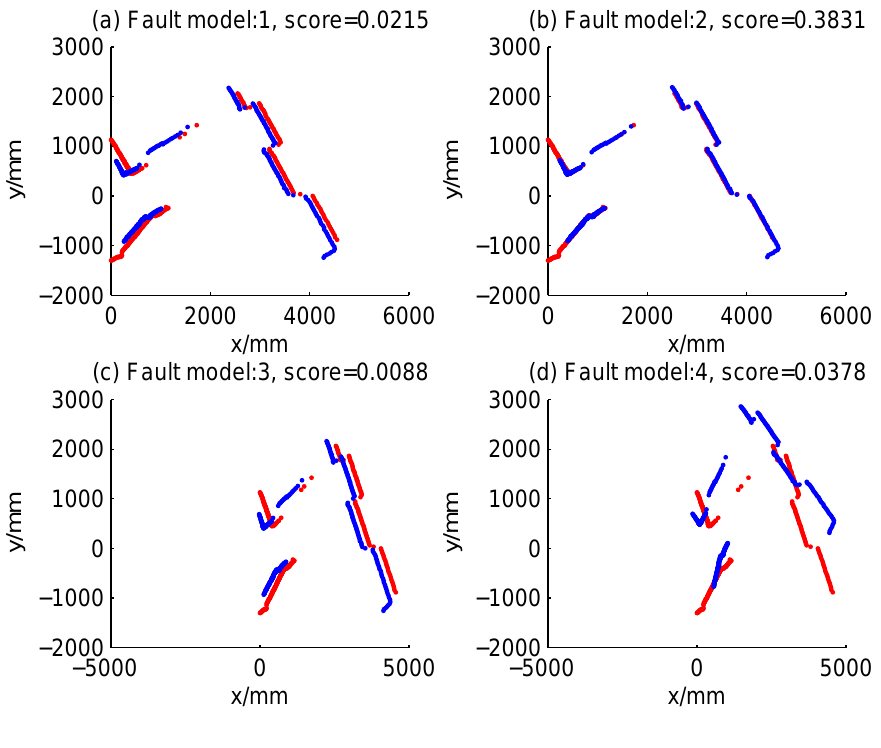
Figure 14. Case 2b: Left encoder stuck, fault model = 2 (time Step 8).